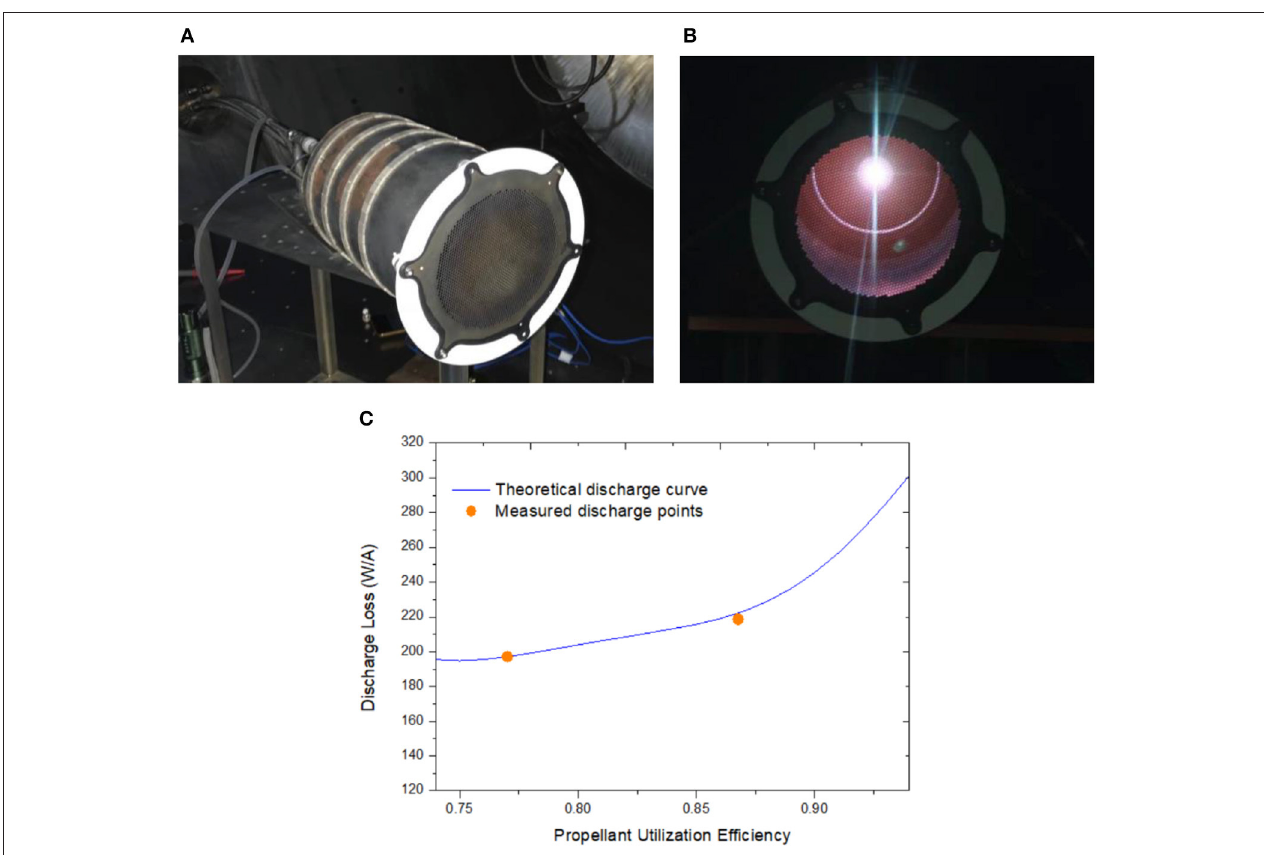
FIGURE 10 | (A) Ion source and screen grid assembly, (B) ion source ignition, and (C) ion source discharge curve.